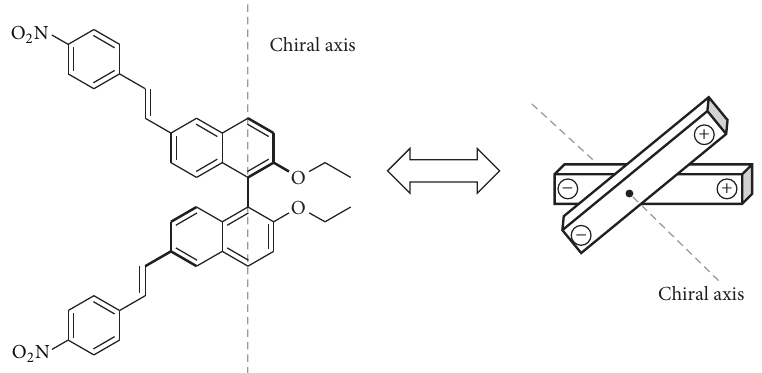
Figure 1: The molecular design for push-pull chiral binaphthyl derivatives [16].